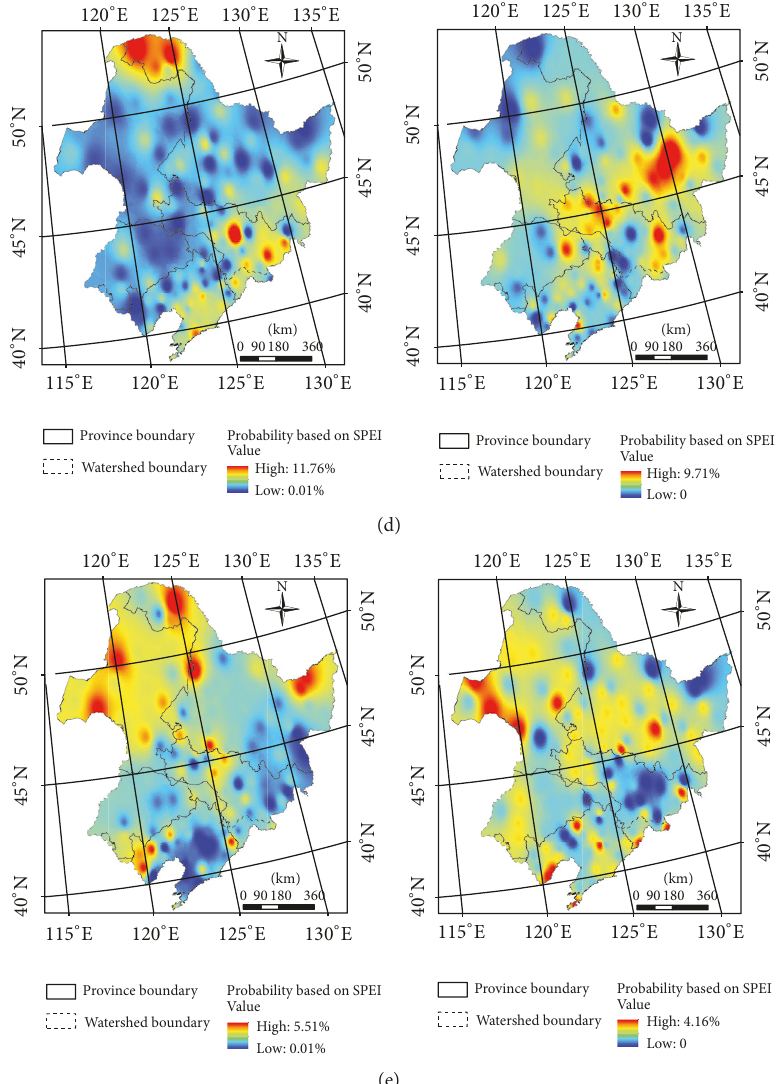
Figure 9: The comparison of spatial distribution of the happening probability of (a) drought, (b) light drought, (c) moderate drought, (d) severe drought, and (e) extreme drought between 1964 and 1994 (left) and between 1995 and 2013